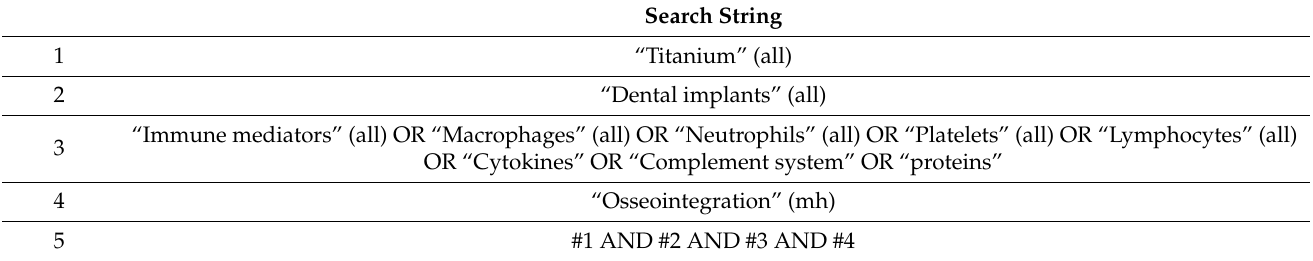
Table 1. Search strategy used. PubMed database, “mh” represents MeSH terms and “all” represents search in all